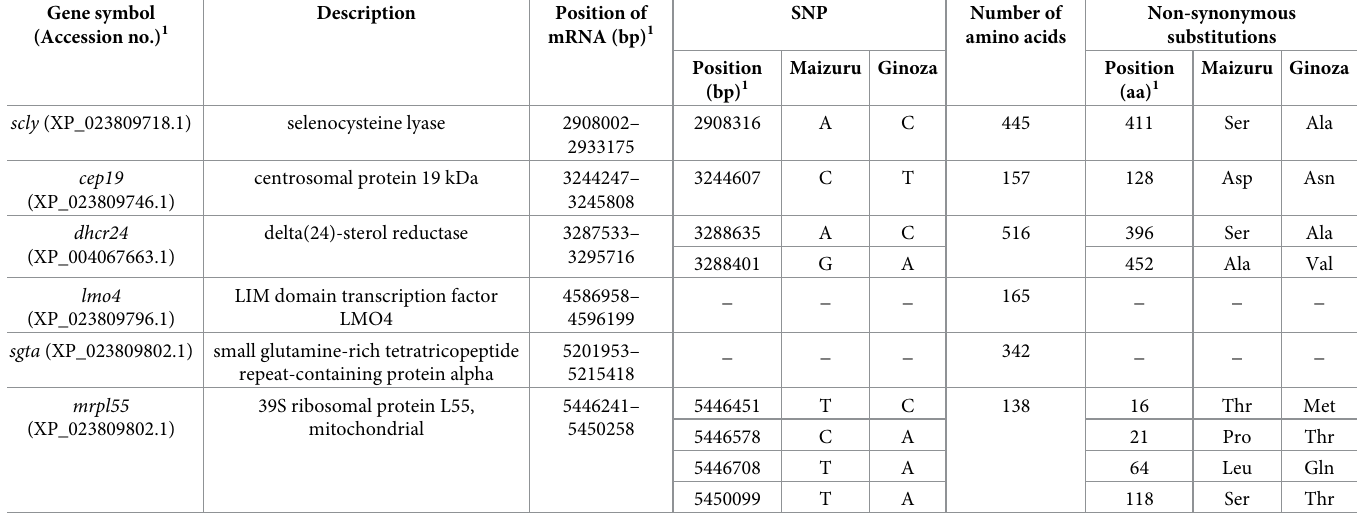
S1 Table. Single nucleotide polymorphism (SNP) markers used for quantitative trait locus (QTL) mapping and genotyping for each SNP in the parental, F Number of markers used for QTL mapping: 371.